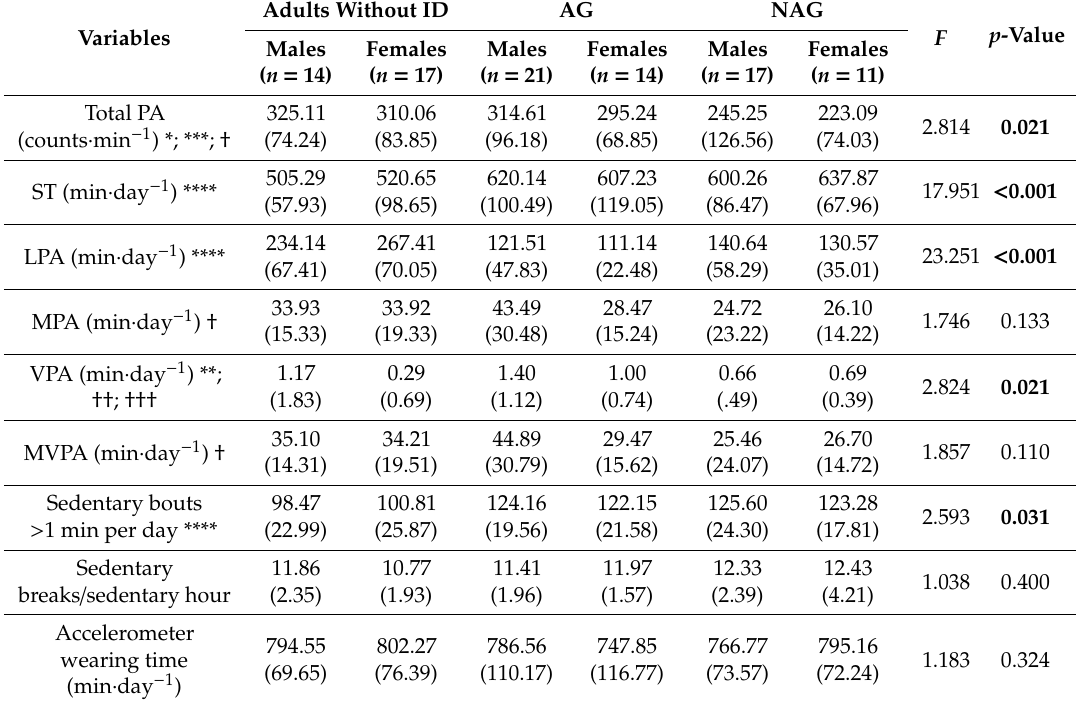
Table 3. Patterns of sedentary time and physical activity levels by group and